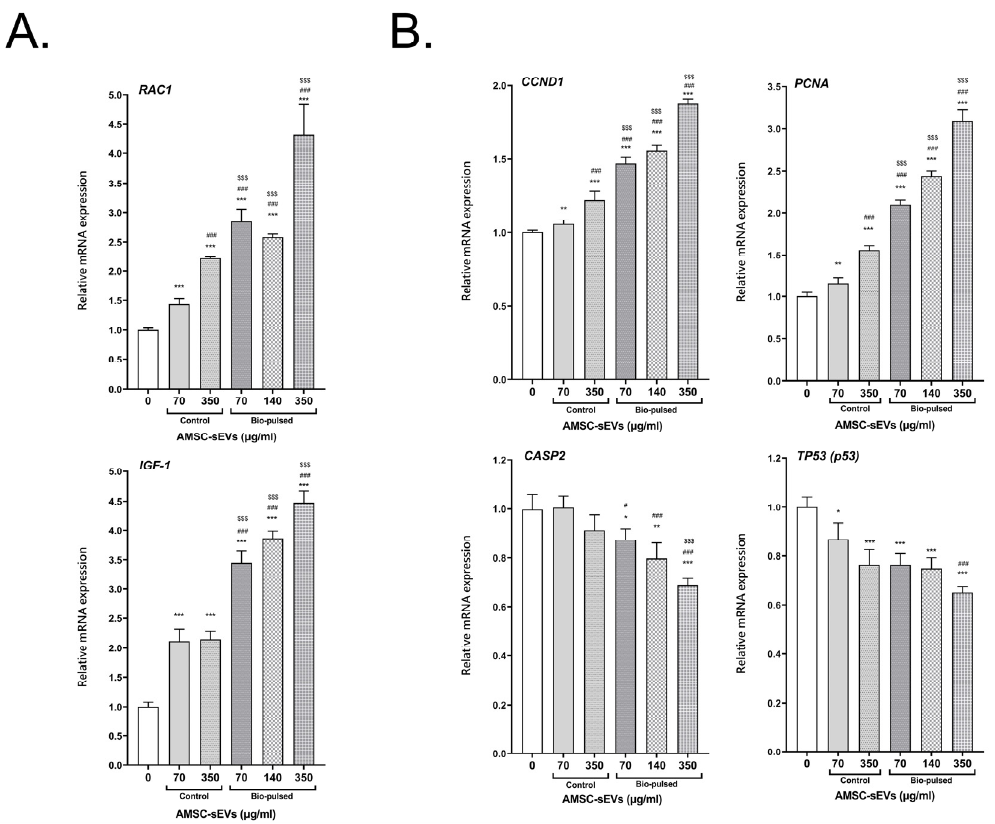
Figure 6. Bio-pulsed avian-derived mesenchymal stem cell (AMSC) sEVs improved hair follicle activity. ( A ) The hair follicle activity-associated genes RAC1 and IGF-1 were significantly augmented after treatment with bio-pulsed AMSC-sEVs for 2 days. ( B ) The cell proliferation of follicle dermal papilla cells was enhanced through the upregulation of the proliferative genes CCND1 and PCNA and the inhibition of the apoptotic genes CASP2 and TP53 after treatment with bio-pulsed AMSC-sEVs for 2 days. (n = 4, data are expressed as the mean ± standard deviation; * p < 0.05, ** p < 0.01, *** p < 0.001, compared with 0 μ g/mL; # p < 0.05, ### p < 0.001, compared with 70 μ g/mL of control AMSC-sEVs group; $$$ p < 0.001, compared with 350 µ g/mL of control AMSC-sEVs